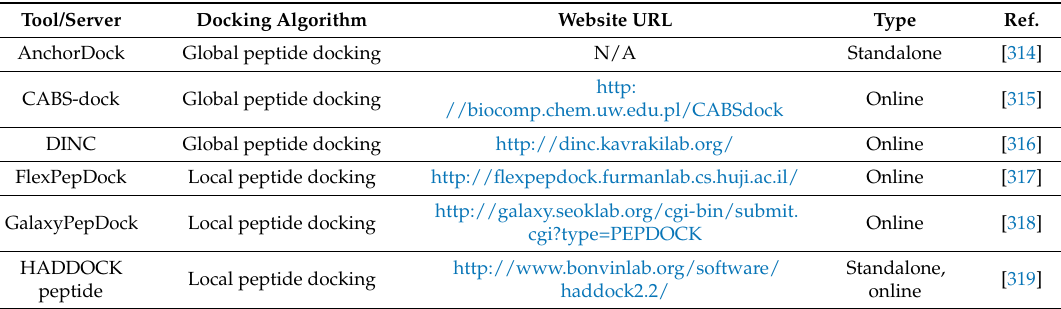
Table 5. Alphabetical listing of available protein-peptide docking